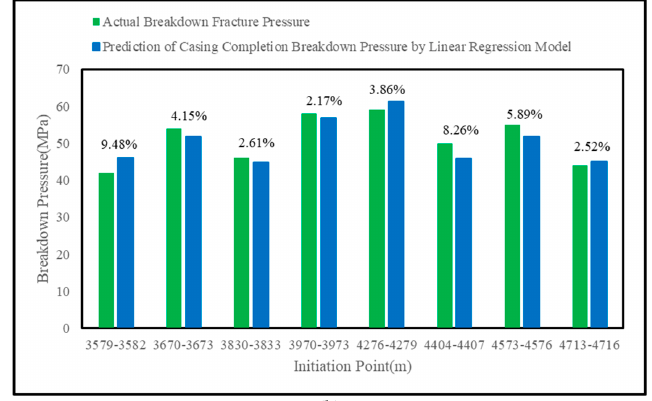
Figure 10. Comparison between actual breakdown pressure and breakdown pressure predicted by the linear regression equation in the site construction of Wells C and D. ( a ) Error analysis of breakdown pressure in Well C. ( b ) Error analysis of breakdown pressure in Well D.